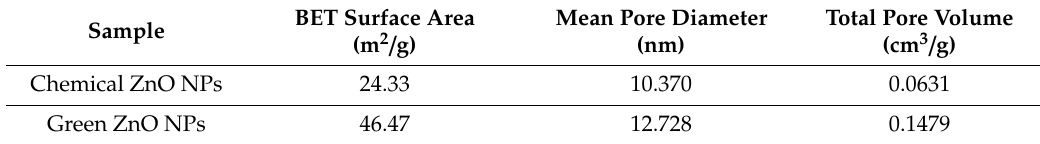
Table 4. BET analysis surface area and the porosity of chemical and green synthesized ZnO NPs.